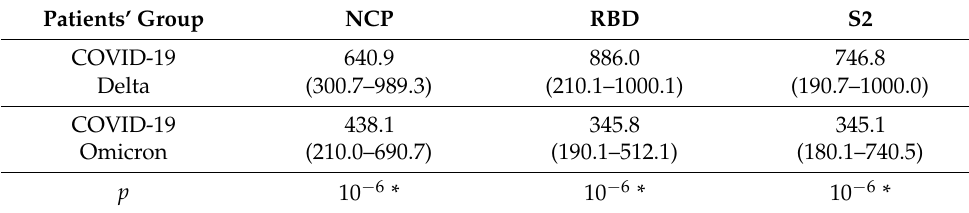
Table 2. The level of NCP, RBD, and S2 (U/mL) in studied groups by SARS-CoV-2 variant.